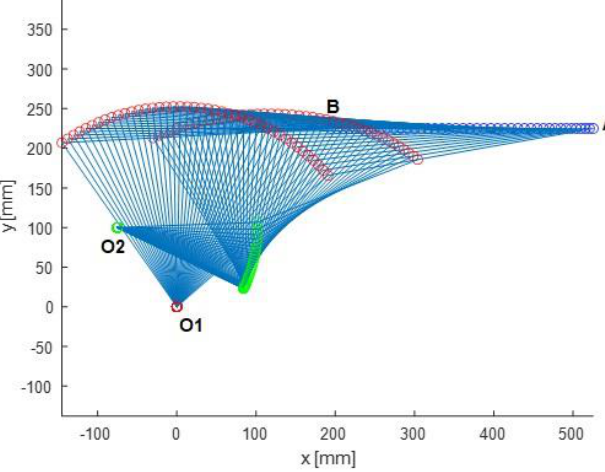
Figure 10. Theoretical trajectory of saw handle.